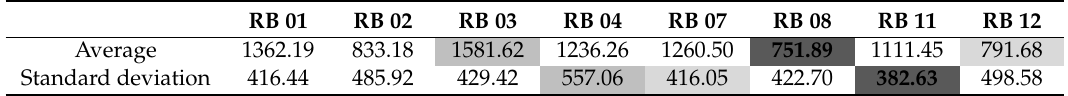
Table 9. Results of RMSE, by representative